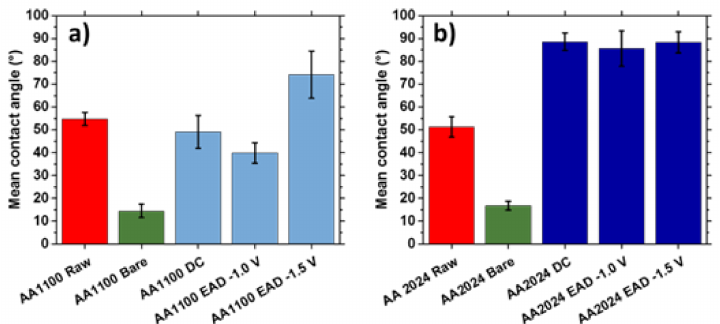
Figure 7. Wettability of ( a ) AA1100 and ( b ) AA2024 substrates before and after the application of the following treatments: Raw (metal plates cleaned with acetone); Bare (metal plates degreased with Saloclean 667N and grinded); DC (dip-coating method); and EAD (electro-assisted deposition at two different